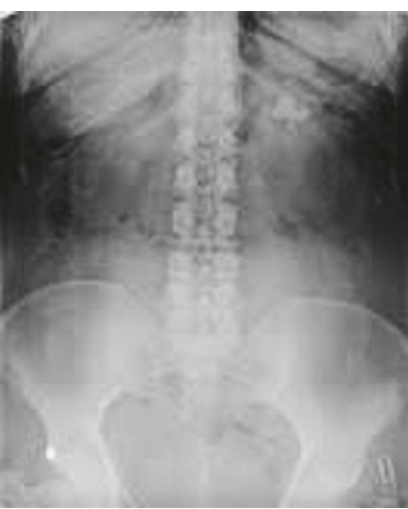
Figure 1: Preoperative plain X-ray of the kidney, ureter, and bladder region showing a partial staghorn left renal stone.